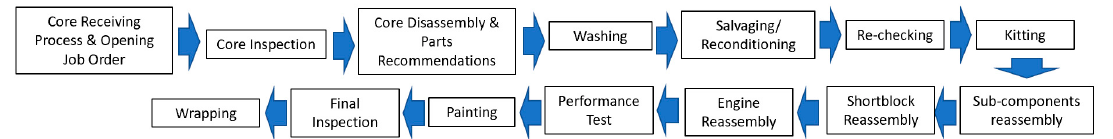
Figure 1. The remanufacturing activities at HeavyEq.